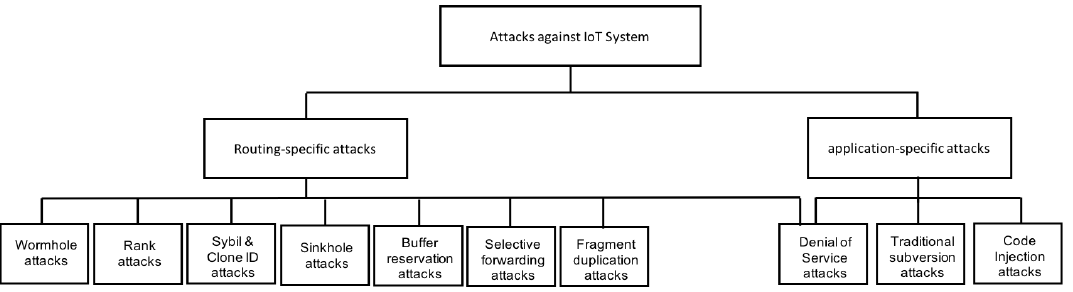
Figure 1. A taxonomy of attacks for IoT